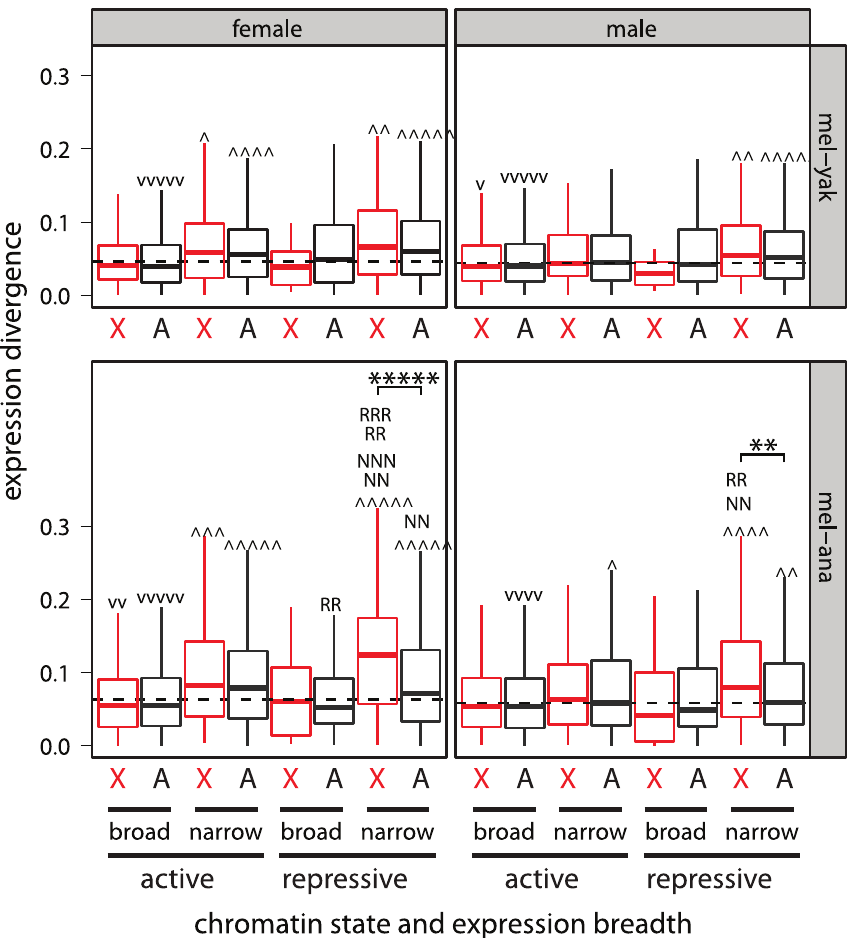
Figure 8. The faster-X effect is limited to narrowly expressed genes in transcriptionally repressive chromatin. Boxplots show the pairwise divergence in expression between 1:1:1 orthologs in the D. melanogaster (mel) and D. yakuba (yak) or D. ananassae (ana) genomes measured in whole females and males (see Figure 5, Figure 6). X-linked (X, red) and Autosomal (A) genes were assigned to transcriptionally active and repressive chromatin based on the results of experiments in S2 cells (for the results from BG3 cells see Figure S15). Groups of genes whose pairwise divergence is greater ^ ð Þ or less (v) than the rest of the genome are marked. Subsets of narrowly expressed genes whose pairwise divergence is significantly different than all other narrowly expressed genes are marked (N). The same was done for subsets of genes in repressive chromatin (R). Significant differences between X-linked and autosomal genes in the same chromatin state and with the same expression breadth are marked with asterisks. Mann-Whitney U tests were used to assess significant differences (one symbol= P v 0 : 05 , two symbols= P v 0 : 005 , three symbols= P v 0 : 0005 , four symbols= P v 0 : 00005 , five symbols= P v 0 : 000005 ).